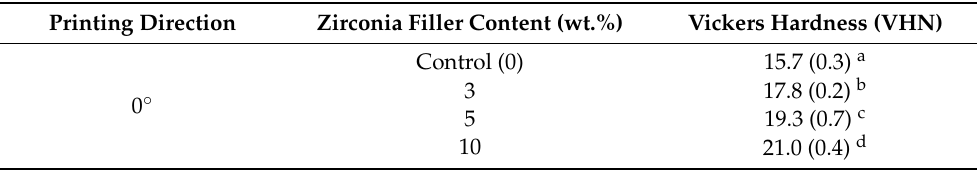
Table 3. Mean (VHN) and standard deviation (SD) values of the Vickers hardness for the test groups in the 0 ◦ printing